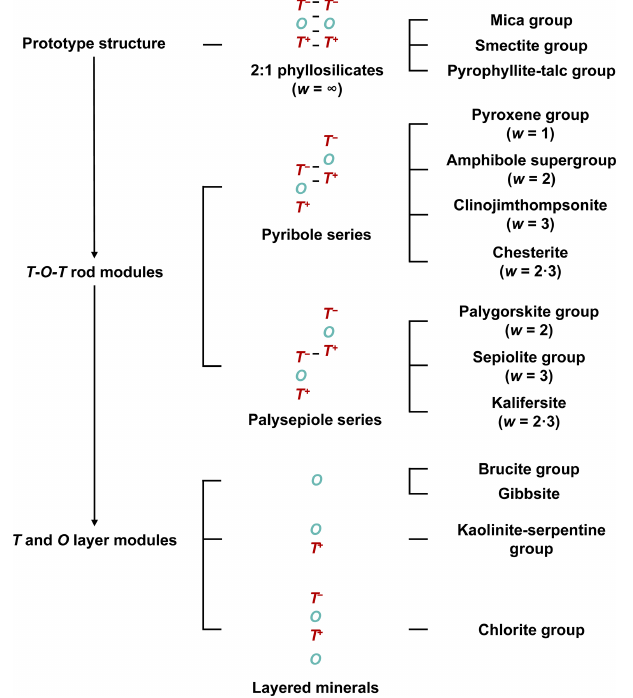
Figure 3. Summary of the crystal-structural relationships between modular minerals that are based on T and O modules. From the 2:1 phyllosilicate prototype structure, T - O - T rod modules are ex- tracted widthwise to construct the crystal structures of the pyri- bole and palysepiole series, whereas T and O layer modules are extracted to construct other layered mineral structures. Visual rep- resentations of the linkages can be seen in Fig. 2b–d. “ · ” indicates that the structures consist of a combination of modules of different widths.